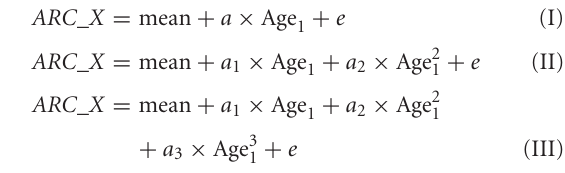
FIGURE 1 | Structural connectivity derived from the measurement of regional gray matter volume. (A) The structural connectivity between the bilateral precentral gyrus (PreCG). (B) The structural connectivity between left PreCG and the left opercular part of the inferior frontal gyrus (IFGoperc). The plots indicate Pearson’s correlation coefficients [ w N ( i , j ) ] between two brain